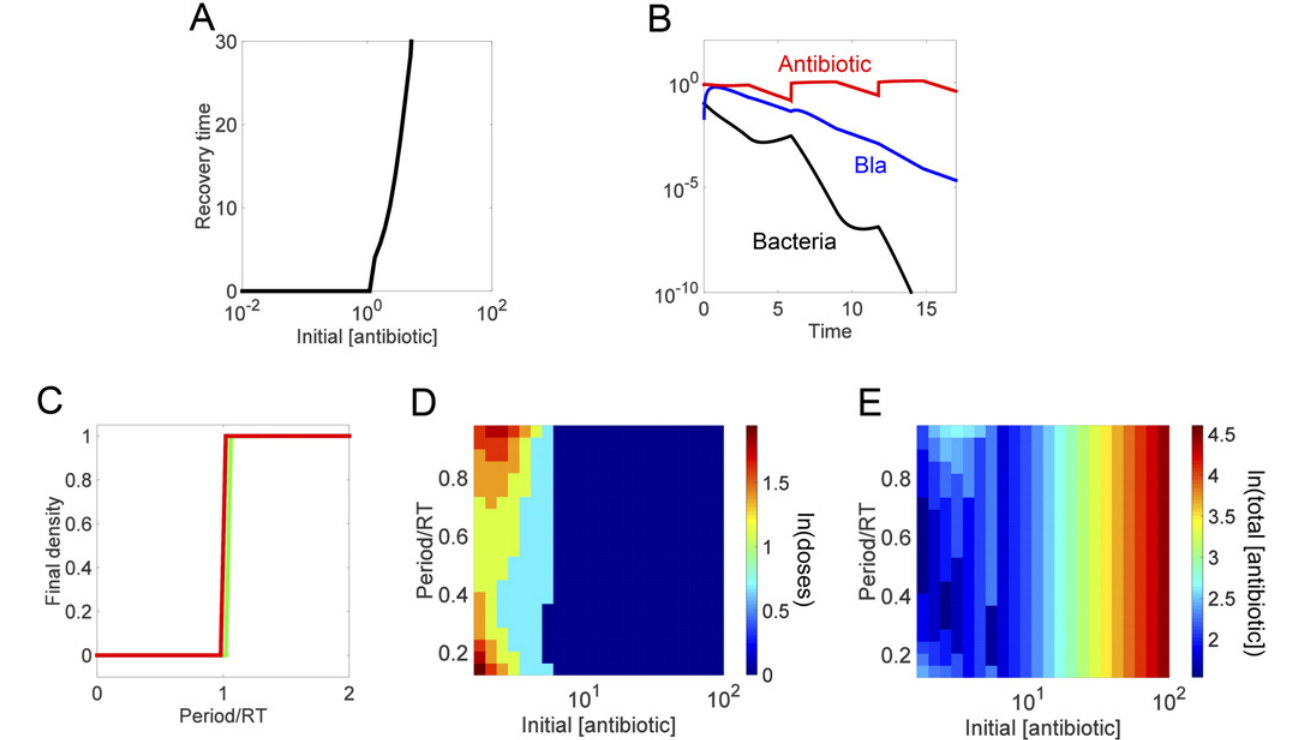
Fig 4. Recovery time guides design of effective intravenous drip based regimen. (A) Dependence of the recovery time on the antibiotic concentration during IV . We maintain each concentration for a fixed duration (time = 3) and then calculate the corresponding recovery time. (B) Time course of an IV-drip regimen . The antibiotic was delivered for a fixed duration until the bacteria density dropped below a pre-defined threshold (10 -10 ). (C) Predictive power of recovery time for the outcome of long-term periodic antibiotic dosing . For each antibiotic concentration-period combination, we calculate the final population density after applying 100 antibiotic doses. (D) Dependence of treatment efficiency on the antibiotic concentration and the dosing period . The efficacy is determined in the same manner as in Fig. 3. (E) Dependence of total antibiotic usage on the antibiotic concentration and the dosing period . The total usage is calculated as in Fig.